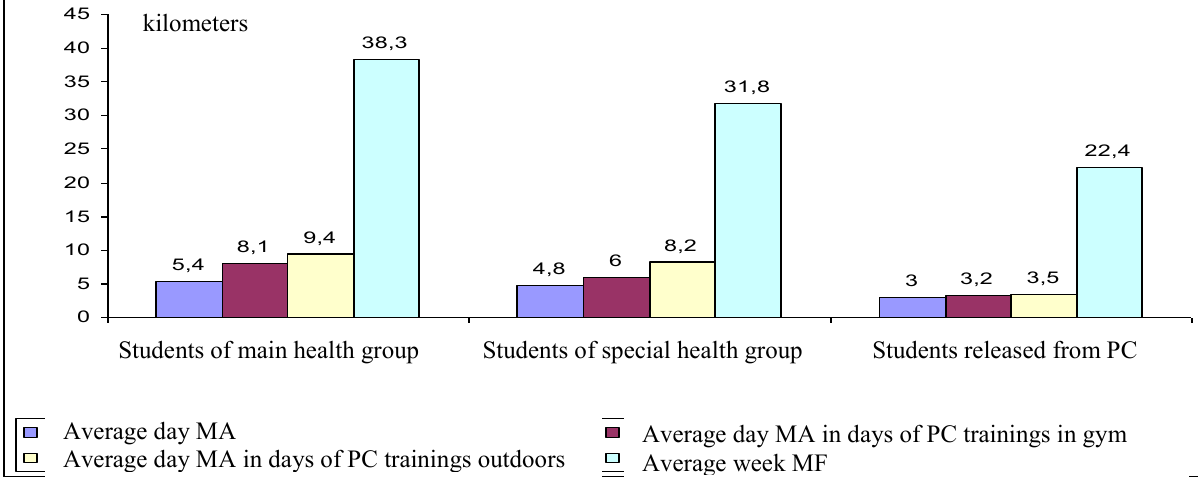
Fig.2. Motion functioning (MF) of students from different health groups (PC – physical